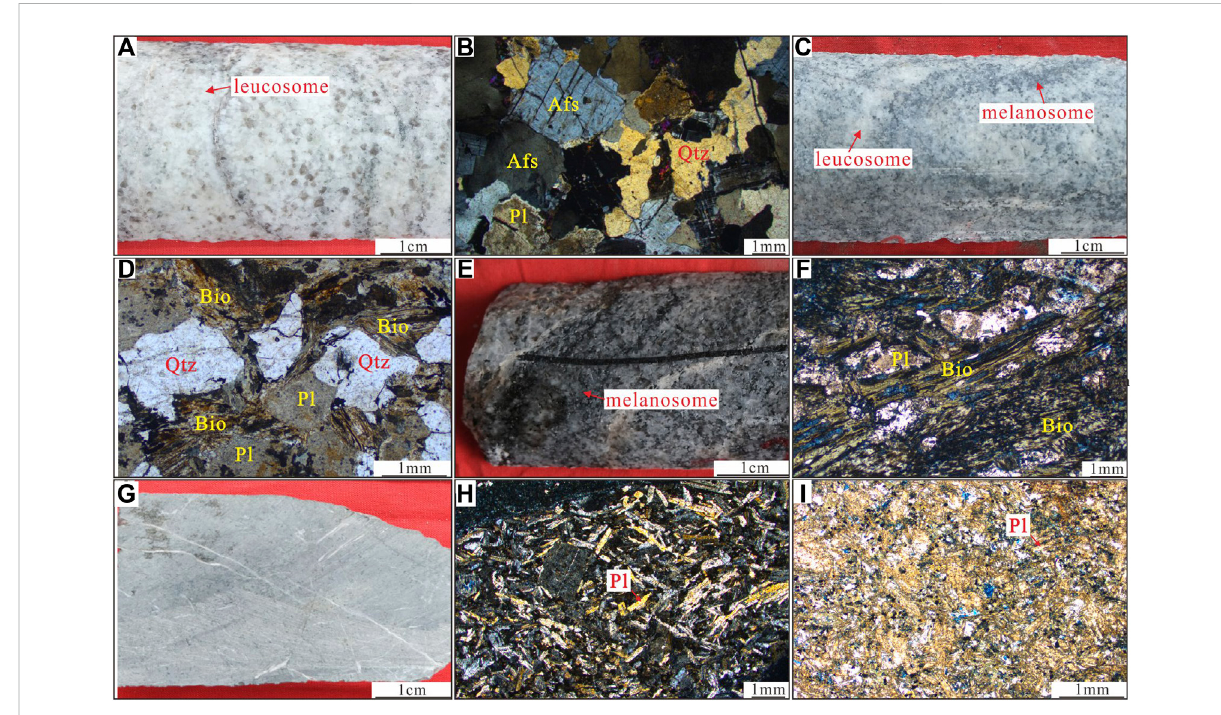
FIGURE 3 Petrological characteristics of the Archean metamorphic rocks in the study area. (A) Migmatitic granite, core, with a typical granitic metamorphic structure and many leucosomes, BZ13-E, 4718m; (B) Migmatitic granite, thin section, with plagioclase, K-feldspar and quartz, BZ19- G,4597m; (C) Migmatitic gneiss, core, the melanosome are usually distributed in massive and strips in the matrix, BZ13-E, 4717m; (D) Migmatitic gneiss,thinsection,thefeldsparsurfaceisstronglyaltered,BZ19-N,4490m; (E) gneiss,core,withobviousgneissicstructure,BZ19-K,5127m; (F) gneiss, thin section, most biotite is lamellar and shows strong chloritization, BZ19-G, 4613m; (G) diabase, core, BZ19-O, 4867m; (H) diabase, thin section, with a typical gabbroic structure, BZ19-B, 4076m; (I) diabase, thin section, with intense alteration, BZ19-G, 4830m; Qtz=quartz, Pl = plagioclase, Afs = alkaline feldspar, Bio=biotite.)